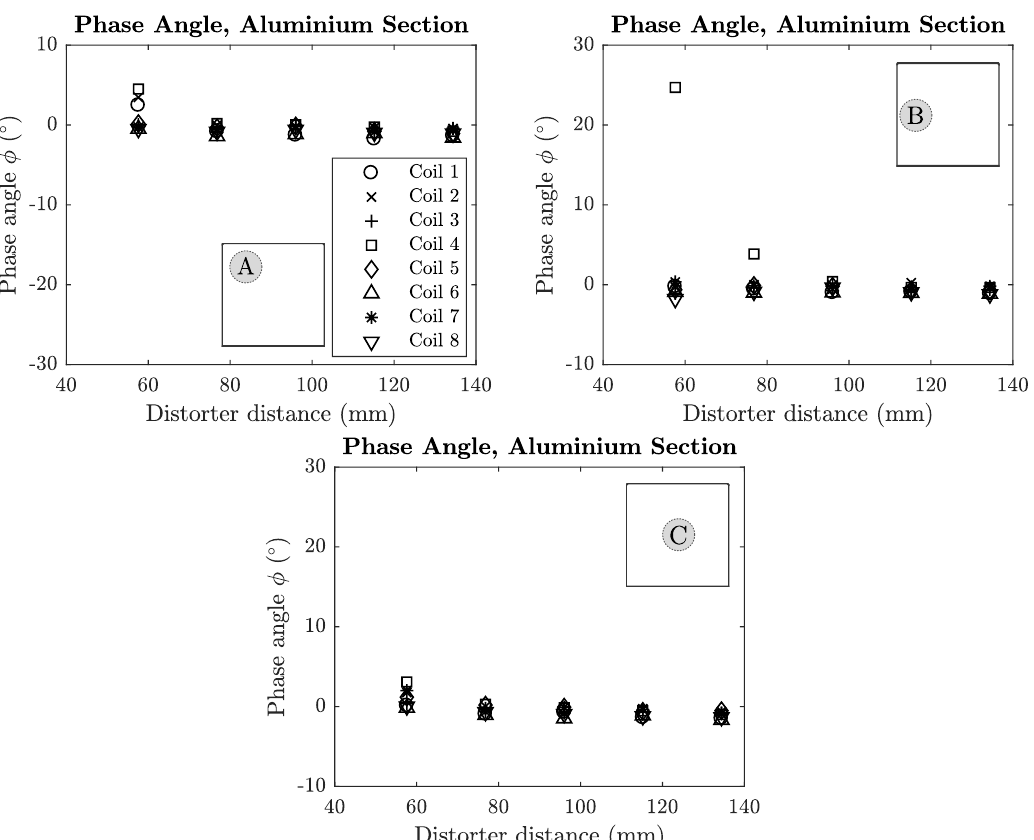
Figure A8. Phase error plots for small aluminium block distorter in locations A, B and C. The largest phase errors are experienced by the in closest proximity to locations A, B and C. Positive phase error is experienced in all cases.